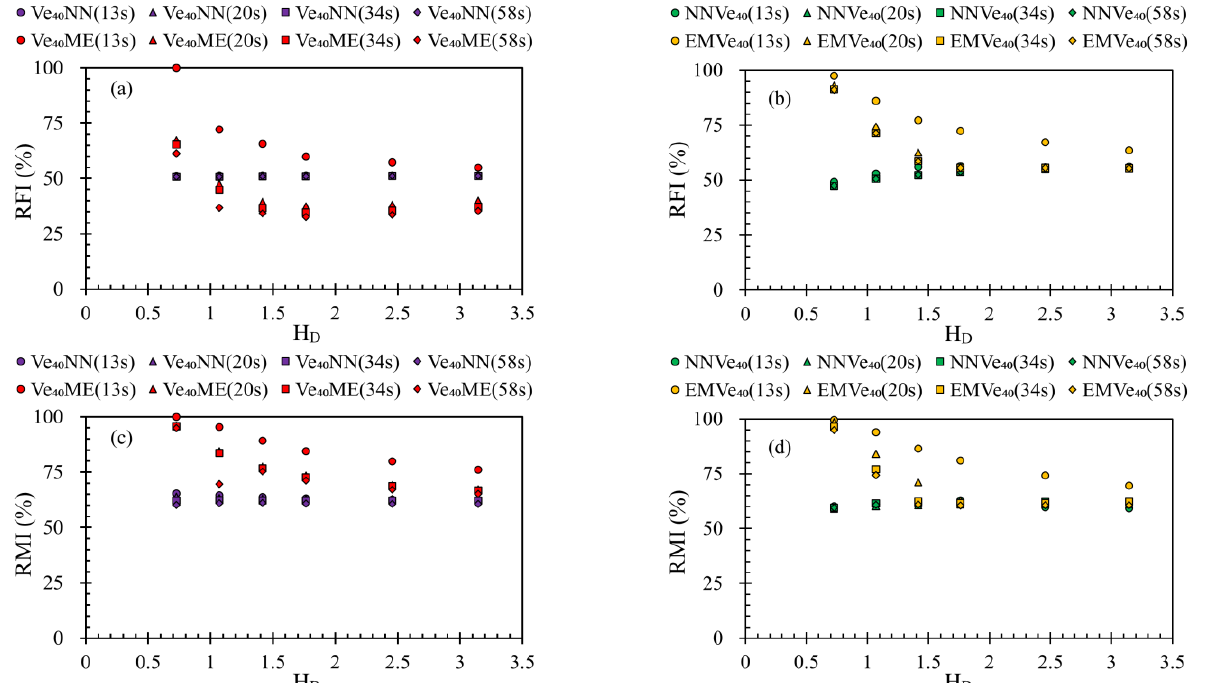
Figure 12. Relationship between H D and RFI or RMI for different hybrid structures. ( a ) RFI: seaward vegetation type, ( b ) RFI: landward vegetation type, ( c ) RMI: seaward vegetation type, ( d ) RMI: landward vegetation type.